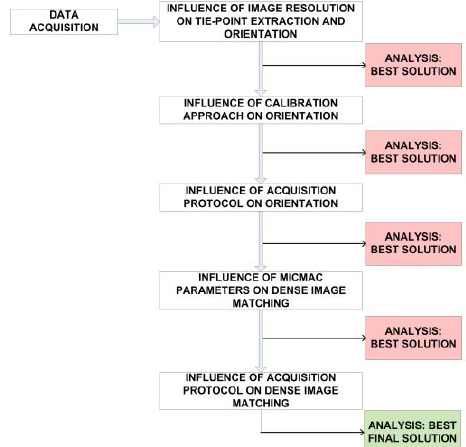
Figure 2. Procedural workflow (Cathédrale de la Major)